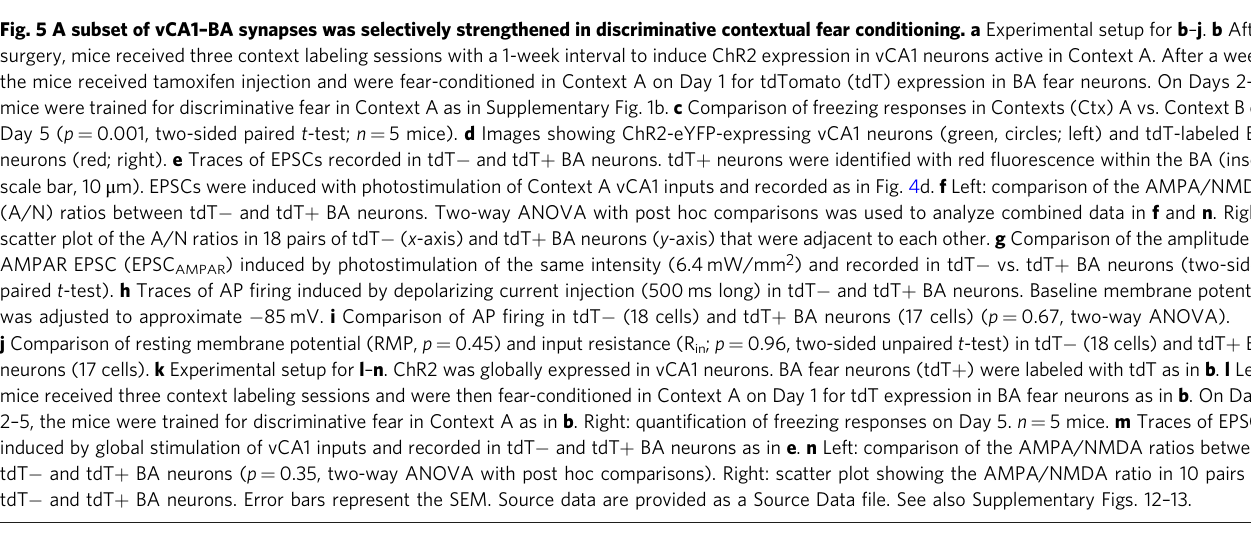
Fig. 5 A subset of vCA1 – BA synapses was selectively strengthened in discriminative contextual fear conditioning. a Experimental setup for b – j . b After surgery, mice received three context labeling sessions with a 1-week interval to induce ChR2 expression in vCA1 neurons active in Context A. After a week, the mice received tamoxifen injection and were fear-conditioned in Context A on Day 1 for tdTomato (tdT) expression in BA fear neurons. On Days 2 – 5, mice were trained for discriminative fear in Context A as in Supplementary Fig. 1b. c Comparison of freezing responses in Contexts (Ctx) A vs. Context B on Day 5 ( p = 0.001, two-sided paired t -test; n = 5 mice). d Images showing ChR2-eYFP-expressing vCA1 neurons (green, circles; left) and tdT-labeled